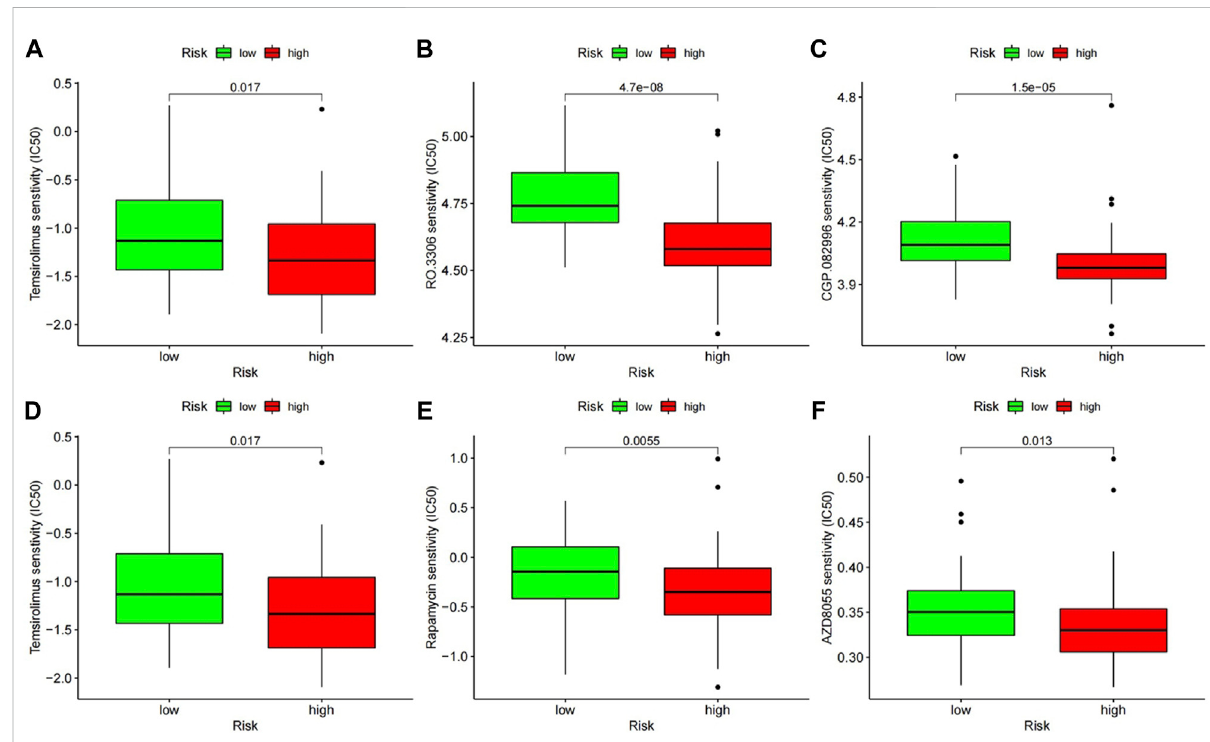
FIGURE 8 The chemotherapeutic responses of two prognostic subtypes to two kinds of pathway inhibitors. (A – C) Inhibitors of mTOR (temsirolimus, rapamycin, and AZD8055). (D – F) Inhibitors of CDKs (roscovitine, RO.3306,